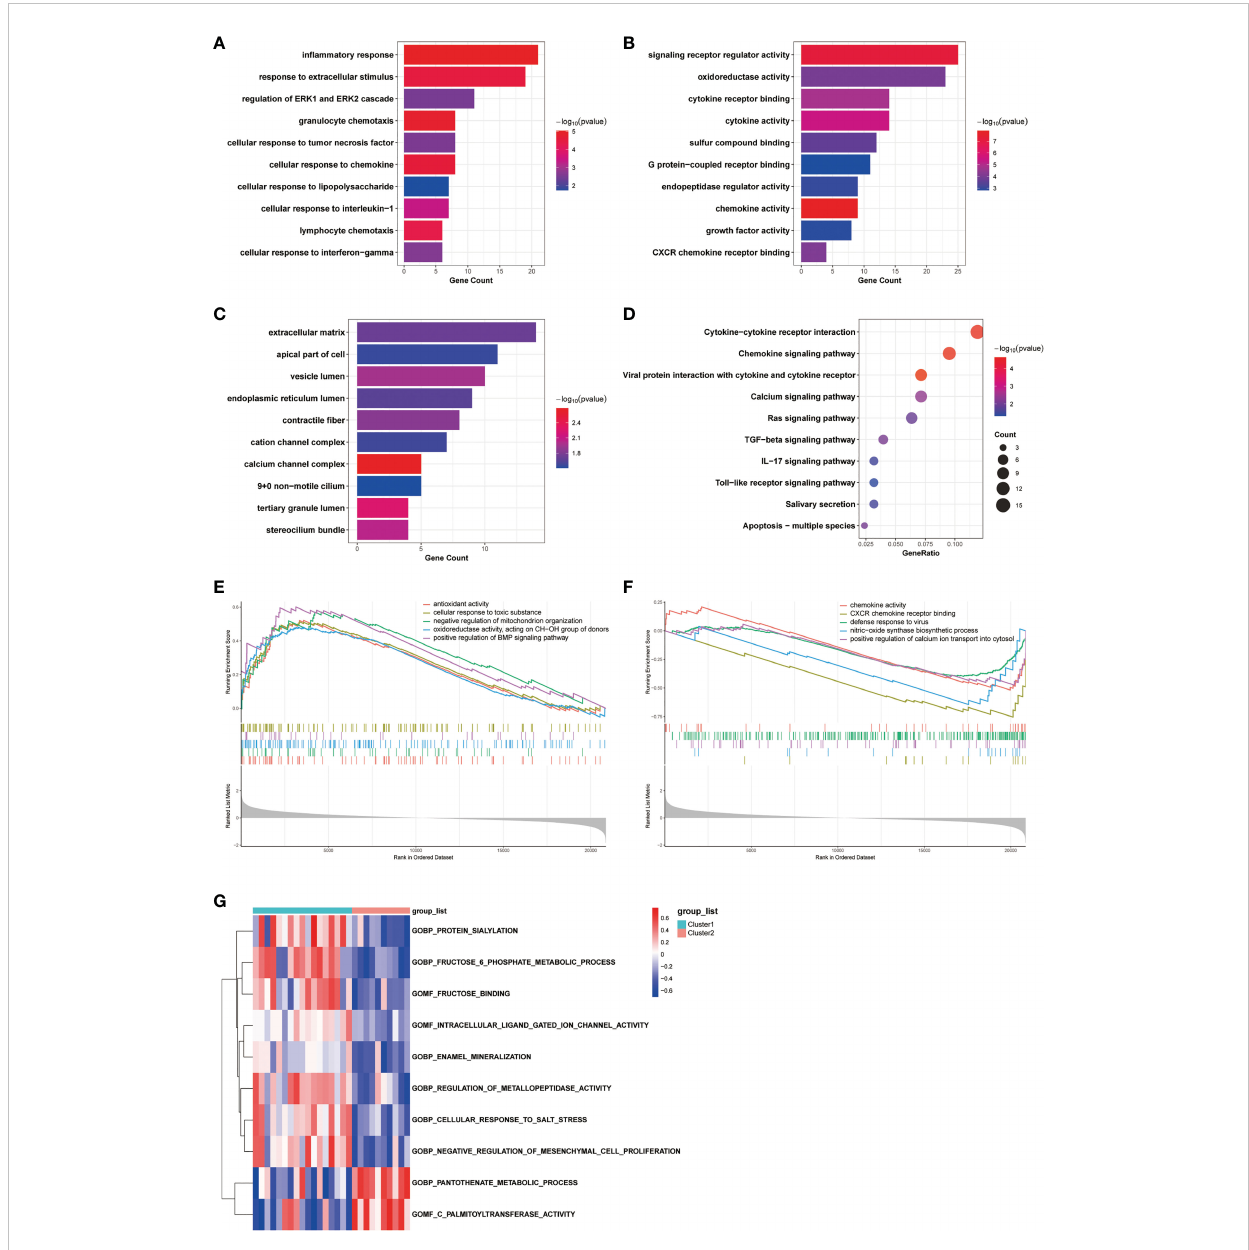
FIGURE 3 Biological characteristics of the two COPD subtypes. (A-C) GO enrichment annotations of DEGs between Cluster1 and Cluster2 in three categories: (A) BP, (B) MF, and (C) CC. (D) KEGG pathway enrichment analysis revealing key signaling pathways of DEGs. (E, F) GSEA analysis of (E) Cluster1 and (F) Cluster2 subtypes. (G) GSVA analysis of Cluster1 and Cluster2